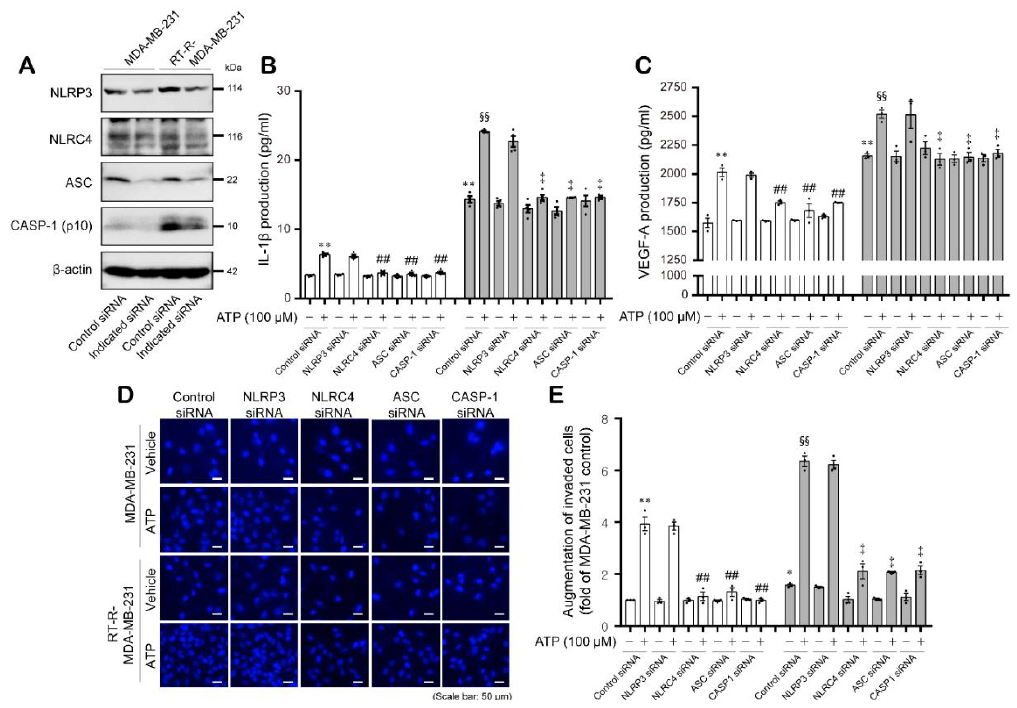
Figure 4. The inflammasome components NLRC4, ASC, and cleaved caspase-1, but not NLRP3, were involved in ATP treatment-enhanced secretion of IL-1 β and VEGF-A and invasion of MDA-MB-231 and RT-R-MDA-MB-231 cells. ( A ) Cells were transfected with siRNA specific to each of the inflammasome components, and the knockdown e ffi ciency was confirmed by Western blotting. CASP-1: caspase-1. ( B , C ) The indicated siRNA-transfected cells were stimulated with ATP (100 µ M) for 24 h. Then, IL-1 β ( B ) and VEGF-A production ( C ) were measured as described in the Methods section. The values represent the mean ± SEM of three independent experiments. * p < 0.05, ** p < 0.01, compared to the control MDA-MB-231 cells; ## p < 0.01, compared to ATP-treated MDA-MB-231 cells; §§ p < 0.01, compared to the control RT-R-MDA-MB-231 cells; ‡ p < 0.01, compared to ATP-treated RT-R-MDA-MB-231 cells. ( D , E ) The indicated siRNA-transfected cells were treated with ATP (100 µ M) for 24 h. Then, Matrigel invasion assays were performed as described in the Methods section. The invaded cells that had crossed the membrane were stained with DAPI ( D ) and counted in three randomly selected fields under a fluorescence microscope ( E ). The values represent the mean ± SEM of three independent experiments. ** p < 0.01, compared to the control MDA-MB-231 cells; ## p < 0.01, compared to ATP-treated MDA-MB-231 cells; §§ p < 0.01, compared to the control RT-R-MDA-MB-231 cells; ‡ p < 0.01, compared to ATP-treated RT-R-MDA-MB-231 cells. Scale bar: 50 µ